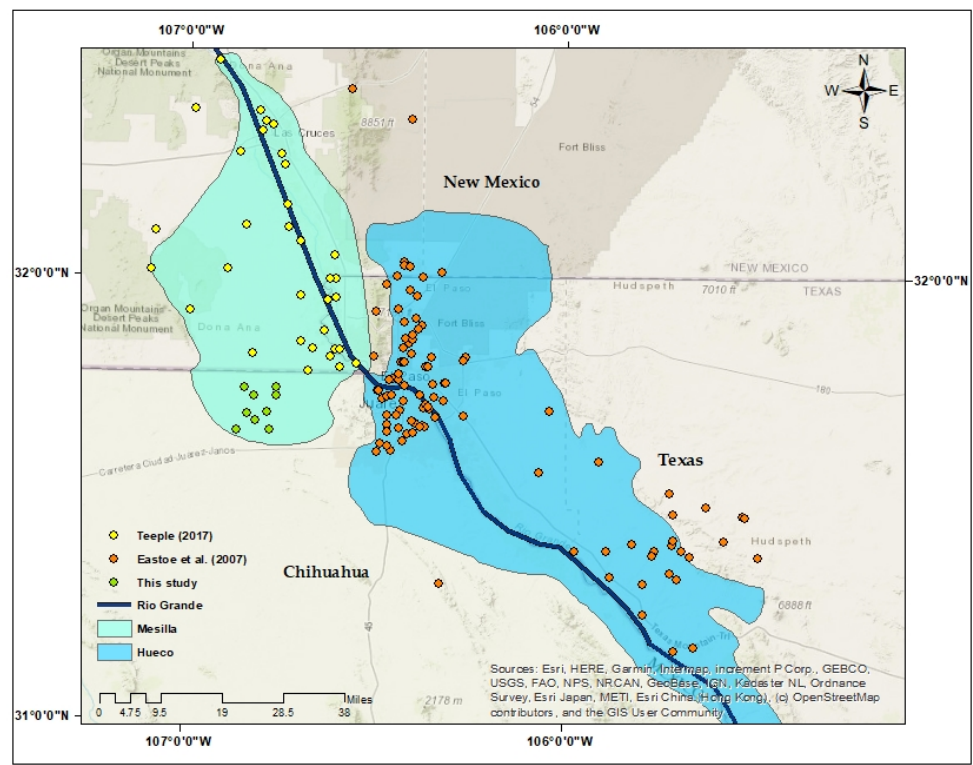
Figure 4. Location of samples collected in this study (green), Teeple (2017) [11] (yellow), and Eastoe et al. (2007) [12] (orange).